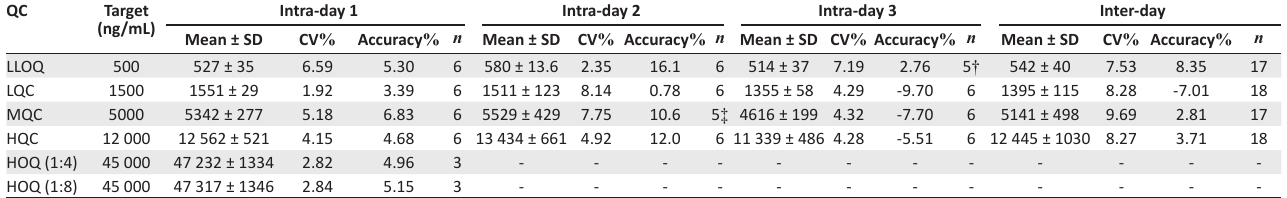
TABLE 1: Inter and intra day accuracy and precision of quality control samples at University of Zimbabwe International Pharmacology laboratory, 2016. QC Target (ng/mL)